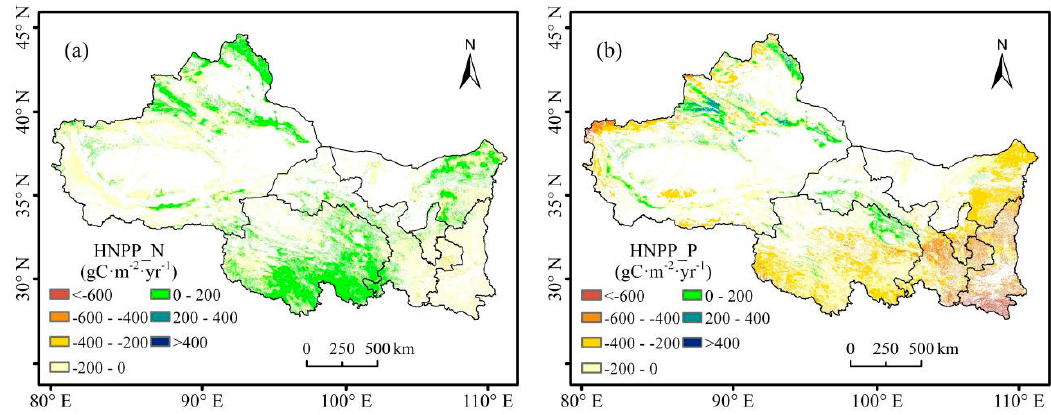
Figure 11. Spatial distribution of HNPP. ( a ) HNPP_N, ( b ) HNPP_P.